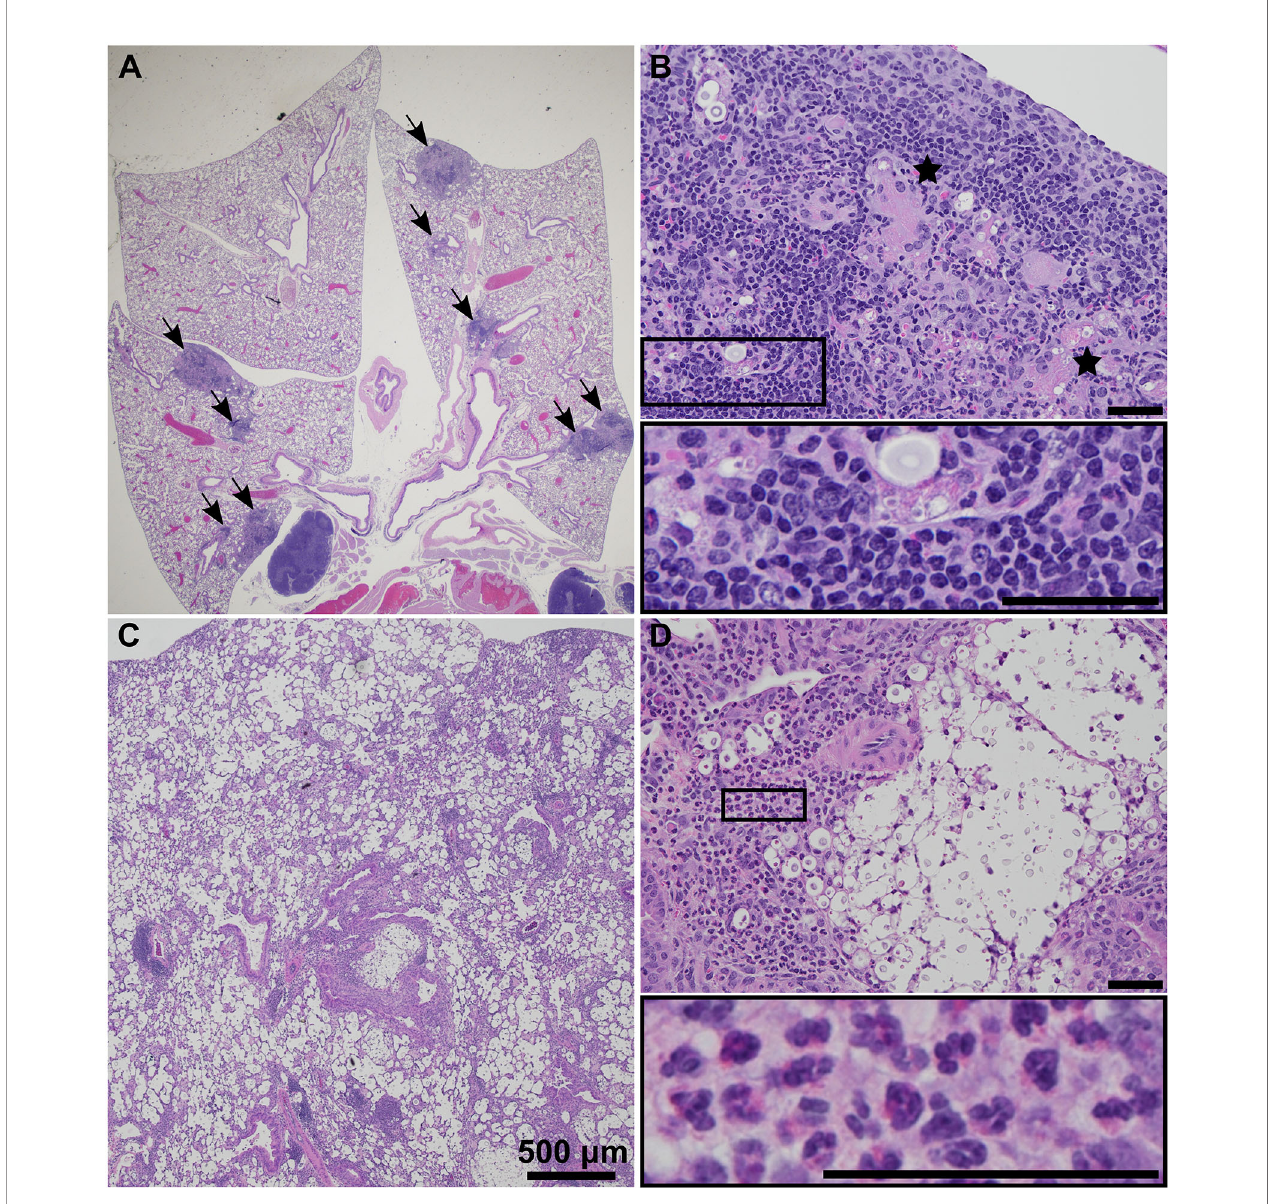
FIGURE 3 | UgCl552 infection was contained within pulmonary granulomas. Representative histopathology images of granuloma formation at (A) 0.5x and (B) 20x magni fi cation in lungs of a C57BL/6 mouse at 35 days post-infection with UgCl552. Black arrows point to granulomas. Black stars mark multinucleate giant cells. (C) 2x and (D) 20x magni fi cation of lungs of a C57BL/6 mouse at 14 days post-infection with KN99 a illustrating C. neoformans cells and in fl ammatory in fi ltrates with PMN ’ s visible in the insert. Scale bars = 50 m m, unless otherwise